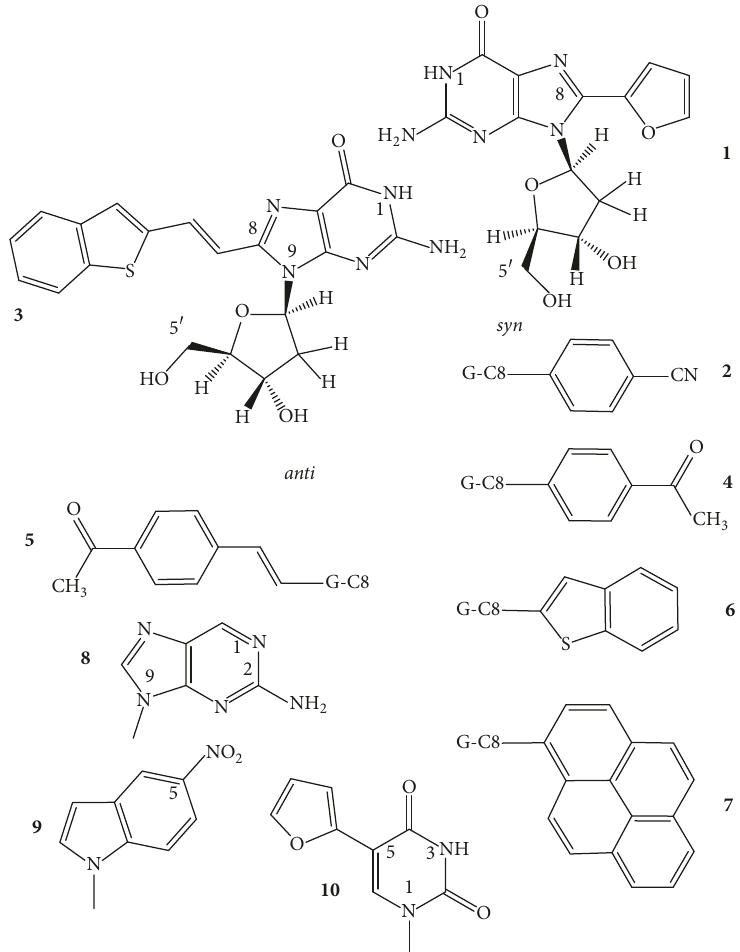
Figure 8: Structures of syn 8-furyl-dG ( 1 ); 8-(4-cyanophenyl)guanine ( 2 ); anti 8-vinyl-benzothienyl-dG ( 3 ); 8-acetylphenylguanine ( 4 ); 8- vinyl-acetylphenylguanine ( 5 ); 8-benzothienylguanine ( 6 ); 8-(pyren-1-yl)guanine ( 7 ); 2-aminopurine ( 8 ); 5-nitroindole ( 9 ); and 5-furyl-2 󸀠 - deoxyuridine ( 10